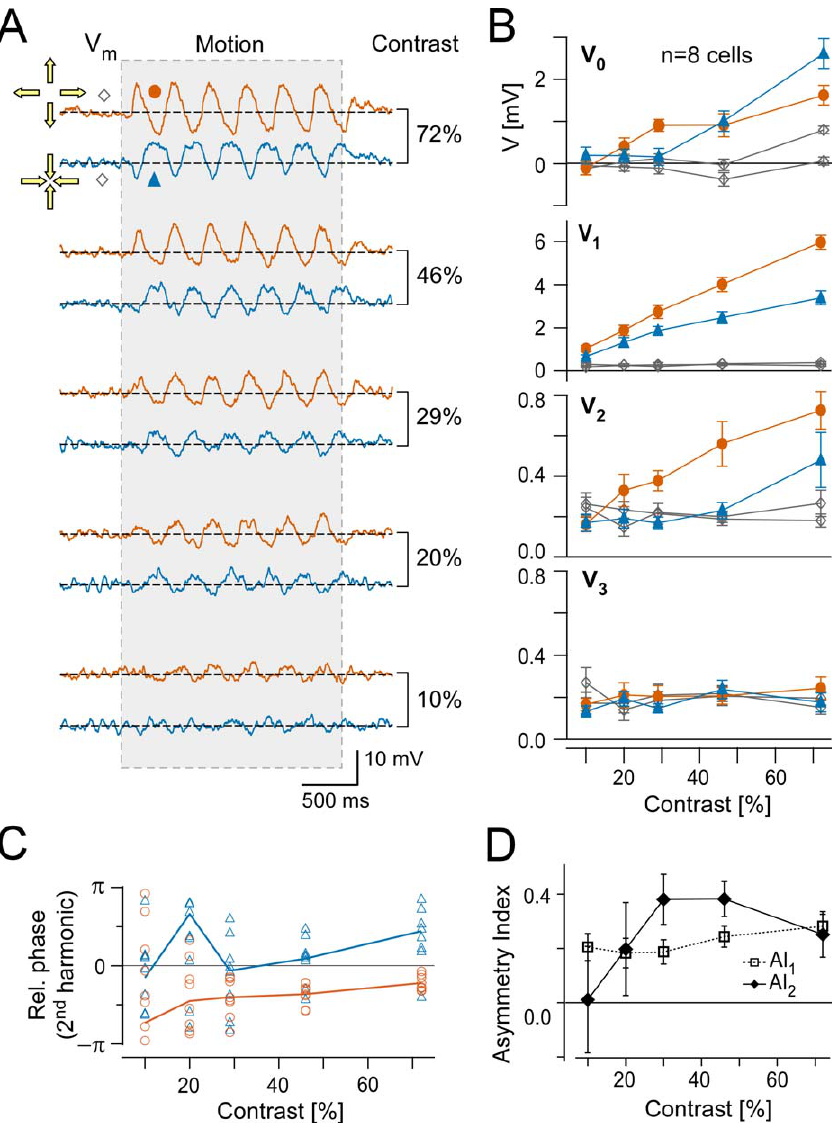
(A) Voltage responses evoked by circular wave stimuli (3 Hz; period: 192 l m, contrasts from 10% to 72%); traces are averages of three trials; CF motion in orange, CP in blue ( V Rest ¼(cid:2) 63 mV). Gray area indicates motion duration. (B) Amplitudes of DC ( V 0 ) , fundamental ( V 1 ) , and harmonics V 2 and V 3 as a function of stimulus contrast (average of eight cells). Prestimulus data (no- motion; open gray symbols) included. (C) Relative phases of second harmonic ( / 2 (cid:2) 2 (cid:3) / 1 ) as function of contrast (same cells as in [B]). (D) AI s for V 1 (open squares) and V 2 (filled diamonds) from (B). For statistics, see Table